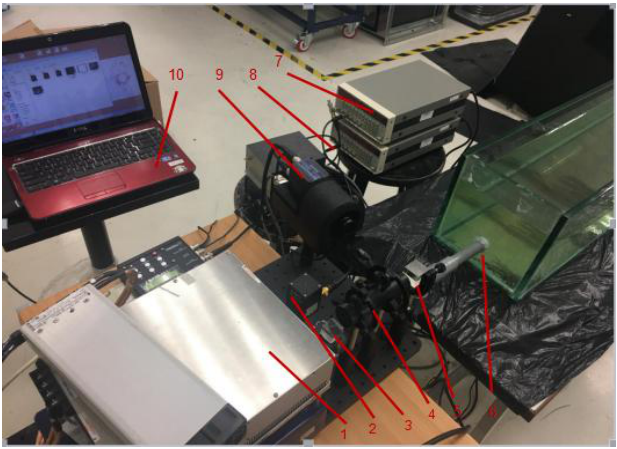
Figure 5. Experimental setup of the proposed gated wavefront sensing system. 1—laser; 2—